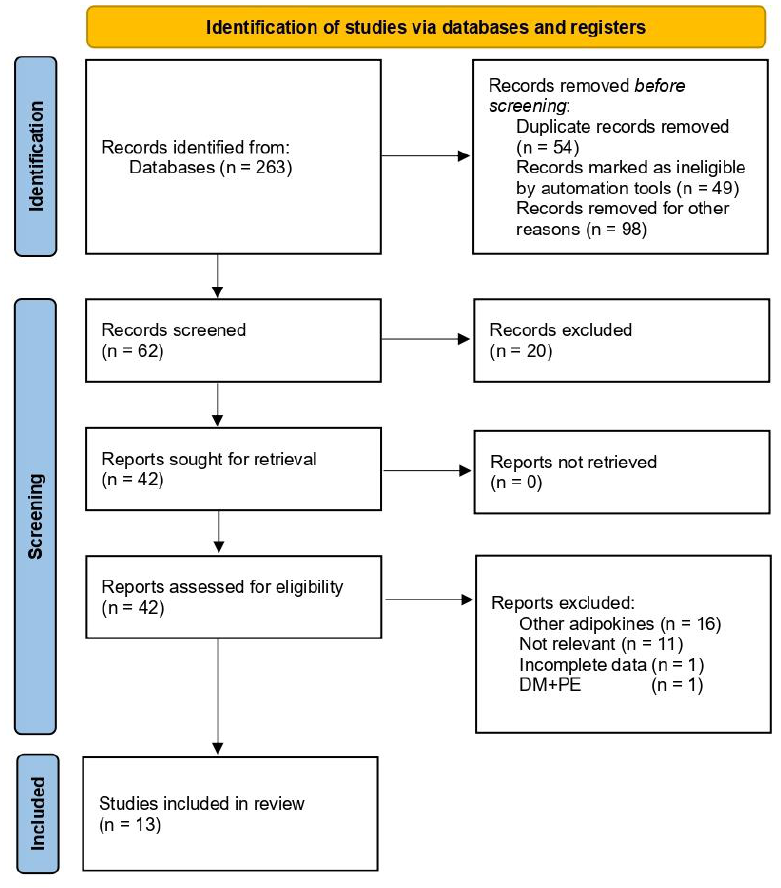
Figure 1. Flow chart showing the study selection